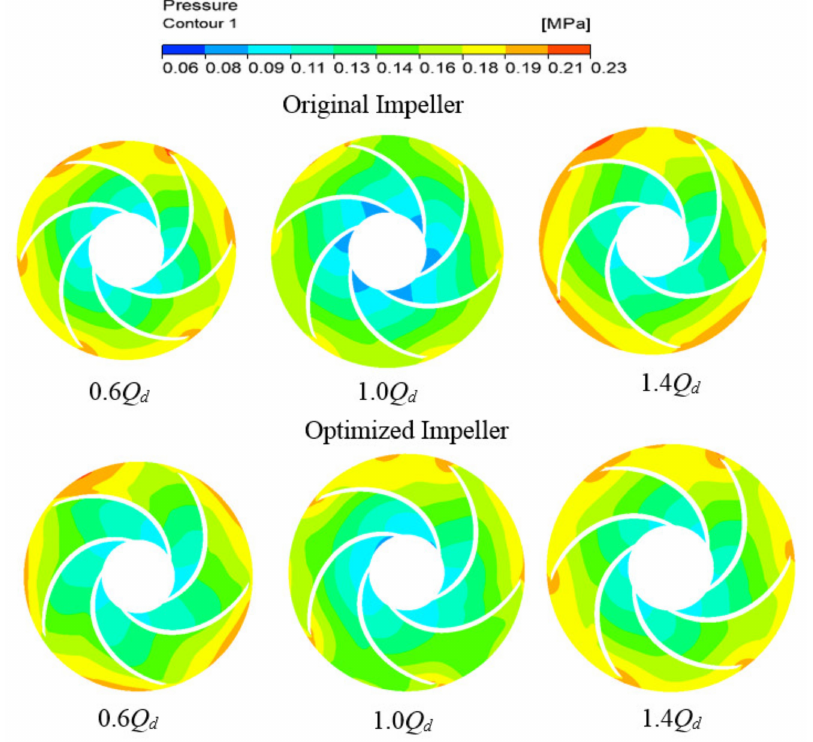
Figure 21. Comparative pressure distribution results for the baseline and optimized